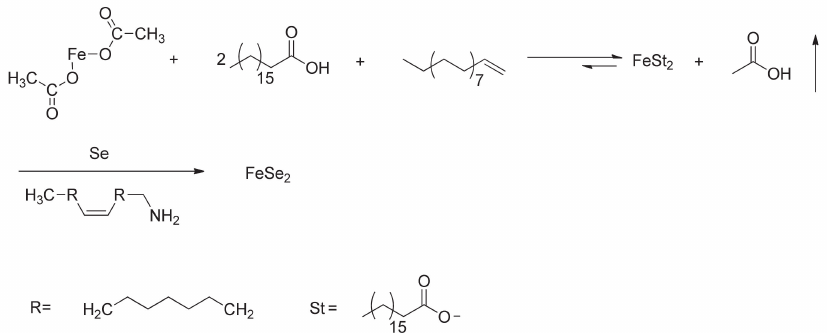
FeSt 2 as an iron precursor and OLA for solubilization of Se.